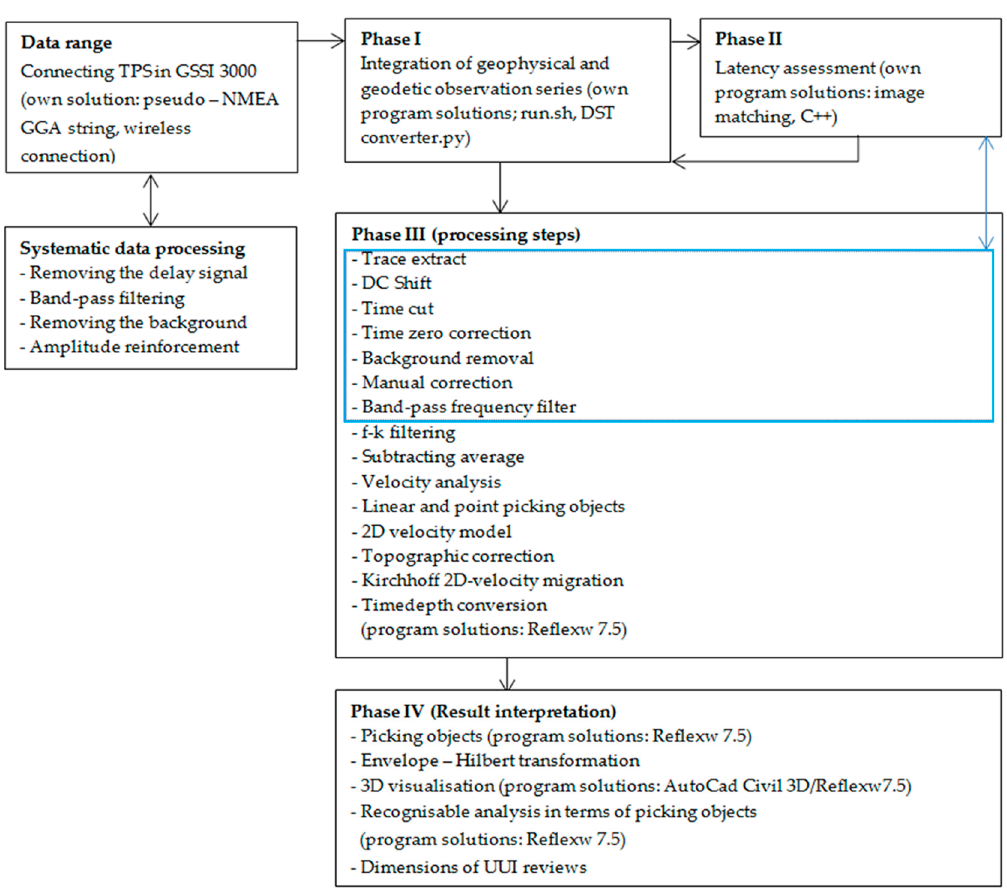
Figure 12. A schematic diagram of the proposed GPR-TPS model for the recording of UUI. Dependent and independent processes related to the central frequency of the antenna used were included in the model. The datasets and parameters independent of the central frequency of the antenna were: the integration of geodetic and geophysical datasets, linear interpolation of the position and the height of the blank traces, latency evaluation, reintegration geodetic and geophysical datasets taking into account the latency, trace extract, time cut, topographic correction, background removal, picking objects and 3D modelling. Table 2 shows the parameters used in the proposed GPR-TPS model, which were dependent on the central frequency of the antenna. Table 2. The procedures and the parameters used in the proposed model of GPR dependent on the central frequency of the antenna. Process